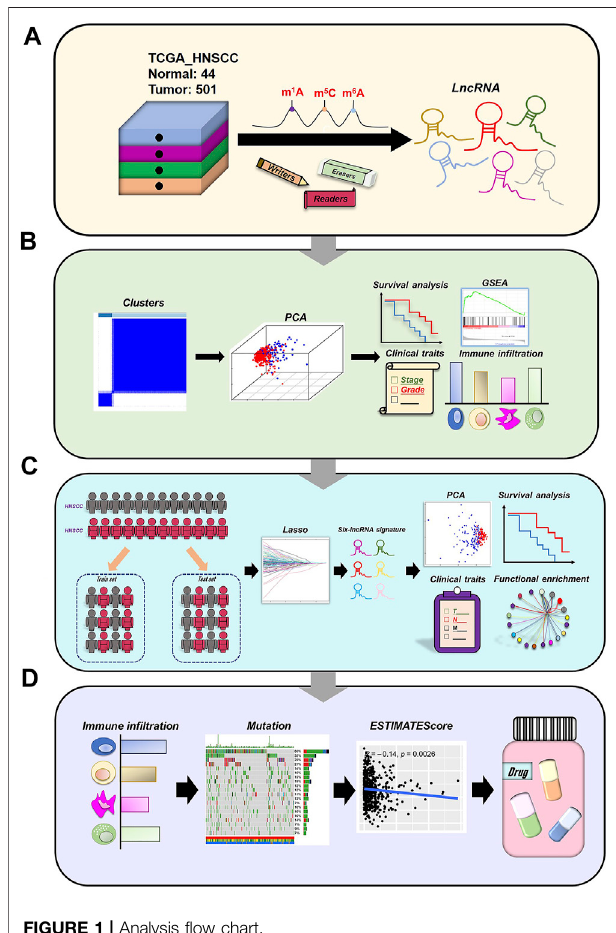
FIGURE 1 | Analysis fl ow